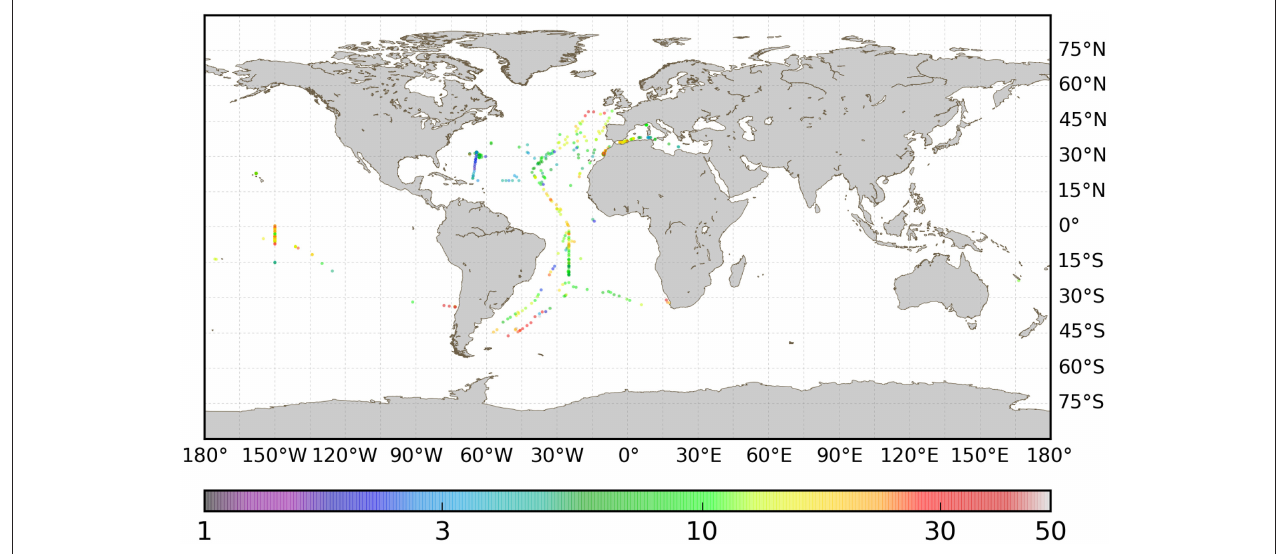
FIGURE 1 | Geographical distribution of the match-up dataset ( N = 557) used for algorithm testing. Color scale is concentration of picophytoplankton, C phy in mgCm − 3 .